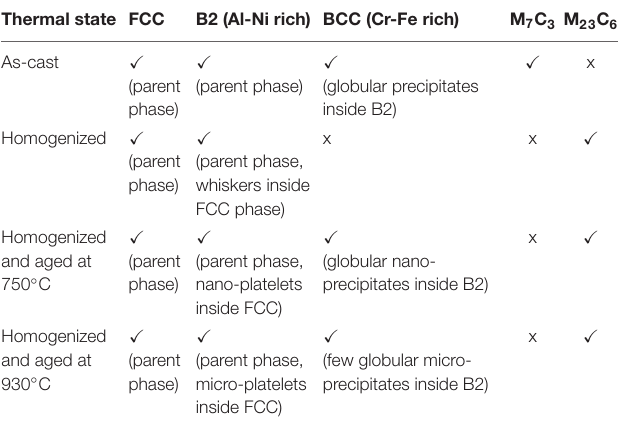
TABLE 3 | Phase identity and morphology as function of the thermal state of AlCrFe 2 Ni 2 alloy. Thermal state FCC